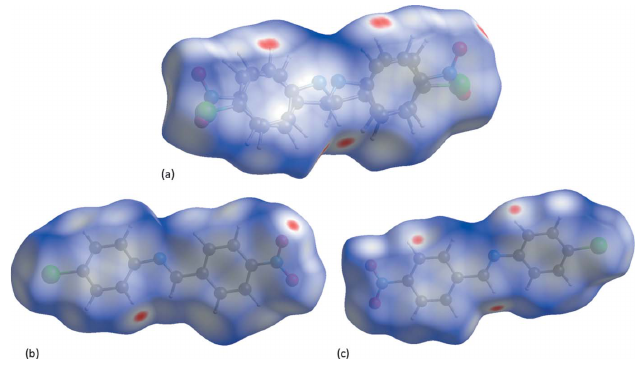
Figure 6 ( a ) The Hirshfeld surface of CNBA mapped over d norm , in the colour range (cid:5) 0.15 to 1.13 a.u., ( b ) the Hirshfeld surface of CNBA_1 mapped over d norm , in the colour range (cid:5) 0.14 to 1.32 a.u., ( c ) the Hirshfeld surface of CNBA_2 mapped over d norm , in the colour range (cid:5) 0.15 to 1.29 a.u.